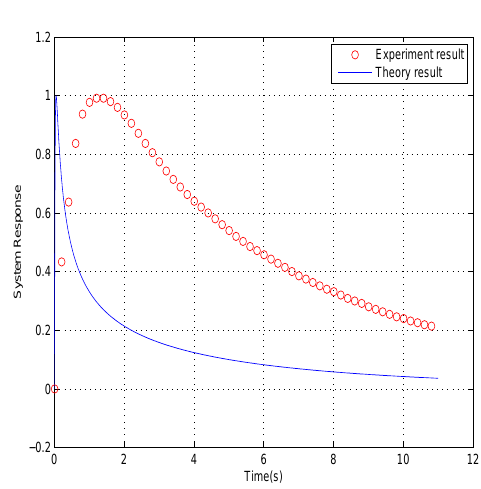
Figure 7. Comparison of the experimental data and theoretical